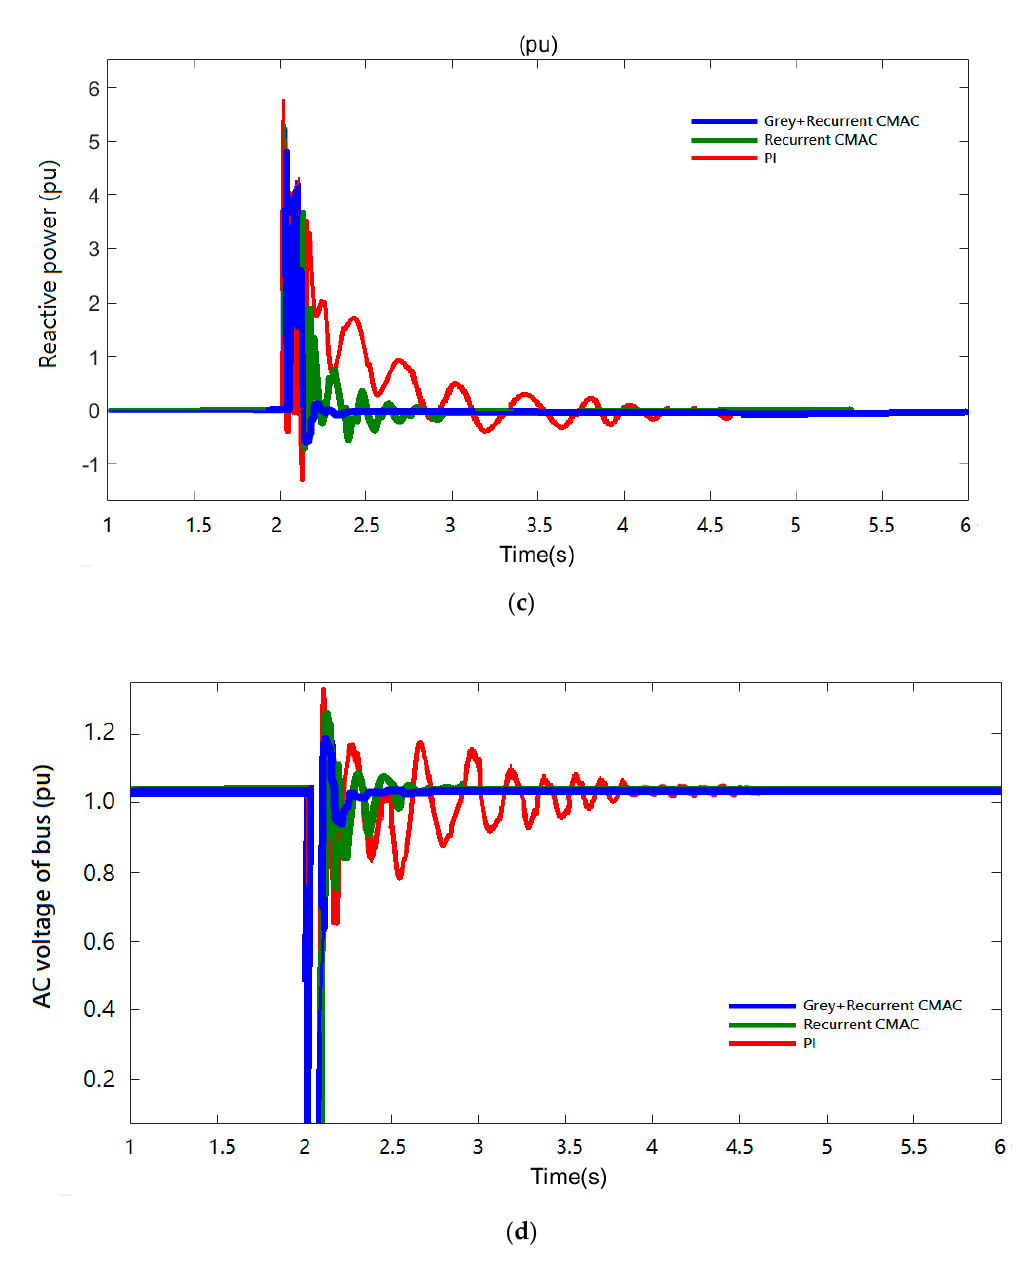
Figure 7. Transient responses of the studied system when a fault occurs: ( a ) generator speed of WECS ( b ) real power of WECS, ( c ) reactive power of WECS, and ( d ) transient voltage amplitude response of AC bus on power grid side. Table 4. Comparison for five controllers when a fault occurs: (a) real power of WECS, (b) reactive power of WECS, and (c) transient voltage amplitude response of AC bus on power grid side.